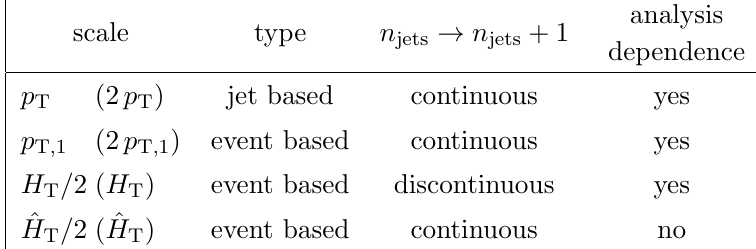
Table 1 . Possible scale choices in inclusive jet production and their